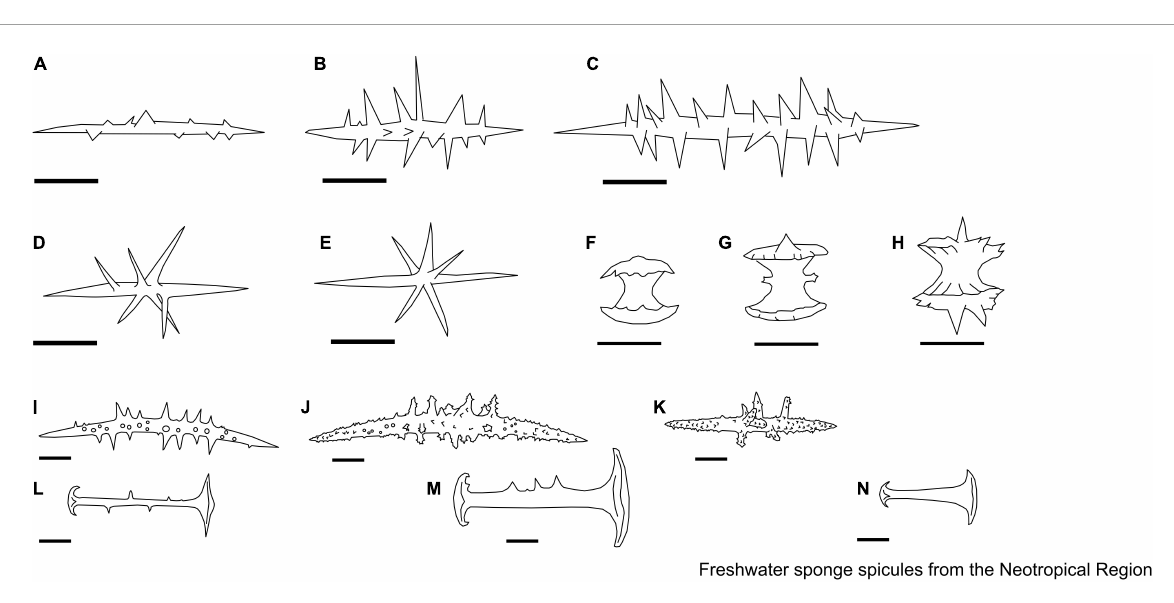
FIGURE12 (A–H) Houssayella Bonetto & Ezcurra de Drago, 1966. Microscleres. (A–C) Acanthoxeas; (D,E) aster. Gemmuloscleres. (F–H) Birotules. (I–N) Metania (Gray, 1867). Microscleres. (I–K) Acanthoxeas. Gemmuloscleres. (L–N) Boletiform. Scale: 10 µ